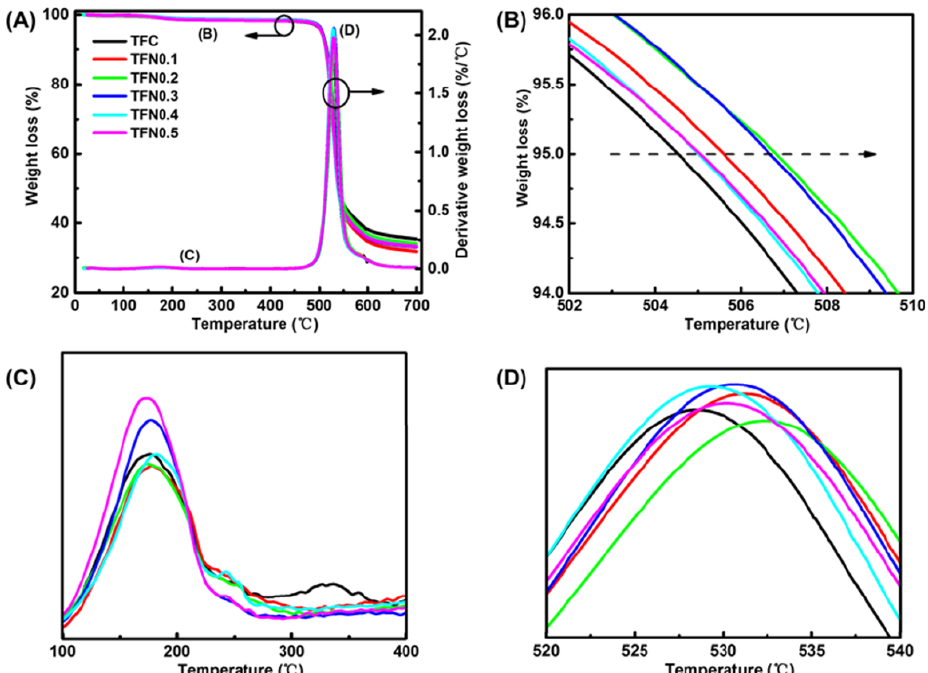
Figure 8. TGA curves of membranes with different PTS loading: ( A ) from 30 ◦ C to 700 ◦ C; ( B ) temperature of 5% weight loss; ( C ) the maximum temperature loss rate from 50 ◦ C to 400 ◦ C; ( D ) temperature of maximum loss rate from 520 ◦ C to 540 ◦